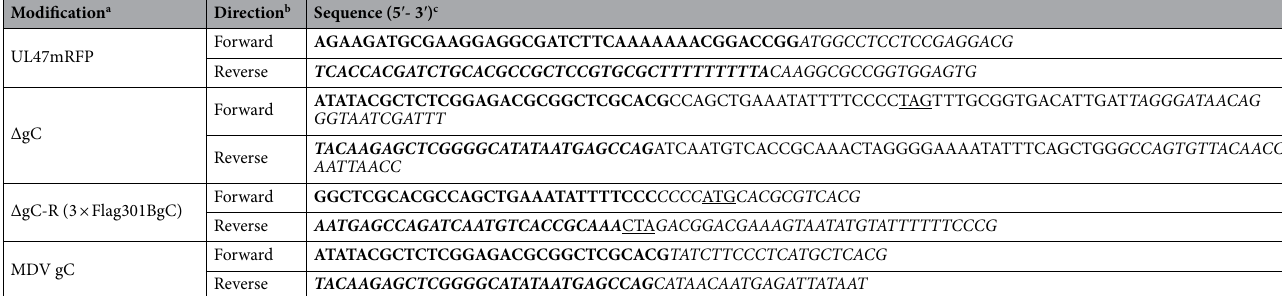
Table 3. Primers used for generation of recombinant Gallid alphaherpesvirus 3 strain 301B/1. a Modification to the 301B/1 genome using two-step Red-mediated recombination. b Directionality of the primer. c Underlined sequence indicates start and stop codons for 301B/1 UL44 gene . Italics indicate the template-binding region of the primers for PCR amplification with pEP-mRFP-in, pEP-KanS2, pEP-301BgC-in, or pEP-MDVgC-in. Bold indicates unique upstream integration sequences. Bold italic indicates unique downstream integration